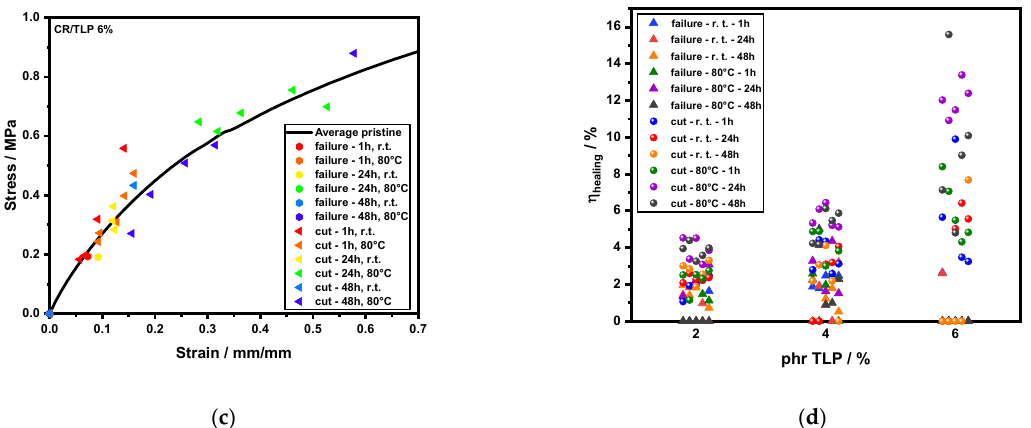
Figure 6. Ultimate tensile strength and tensile strain comparison between healed compounds to cured compounds: ( a ) CR/TLP 2%; ( b ) CR/TLP 4%; ( c ) CR/TLP 6%; ( d ) healing efficiency comparison after failure and after cutting, where five repeats for each condition were performed.